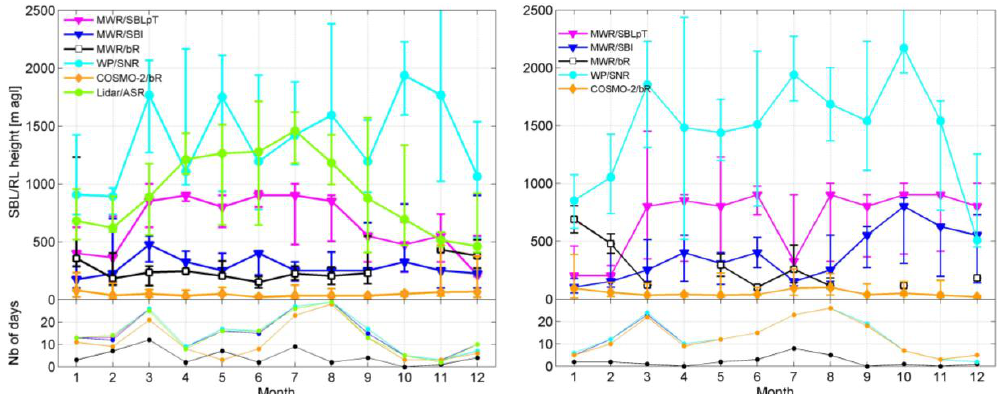
Fig. 11: Upper panel: SBL and RL heights for clear-sky conditions at PAY (left) and SHA (right). Lower panel: number of cloudy-CBL days used to calculate the monthly medians for each method, the colors correspond to the upper panel ones. Symbols and colors as in Fig. 9.